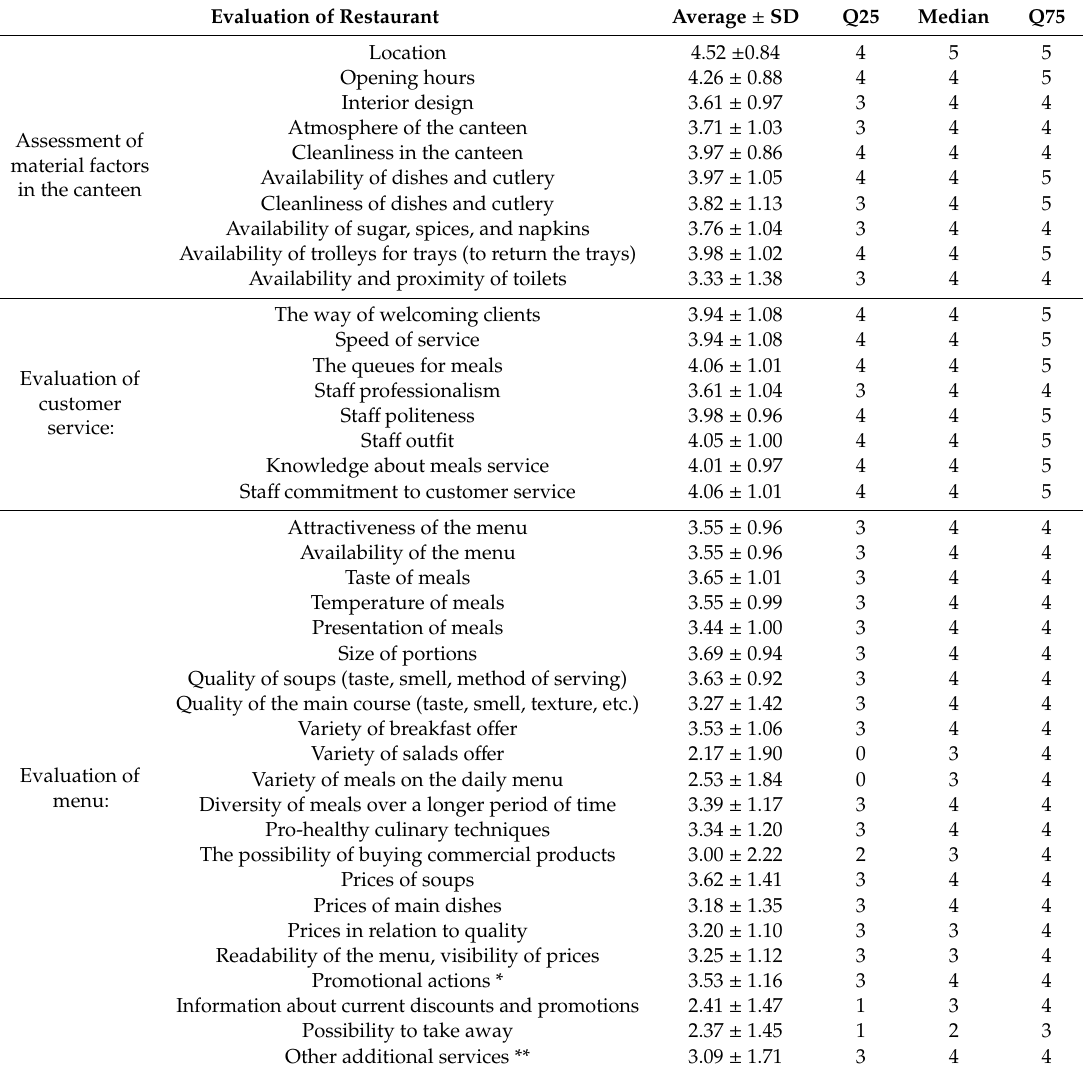
Table 4. Evaluation of sta ff canteens by